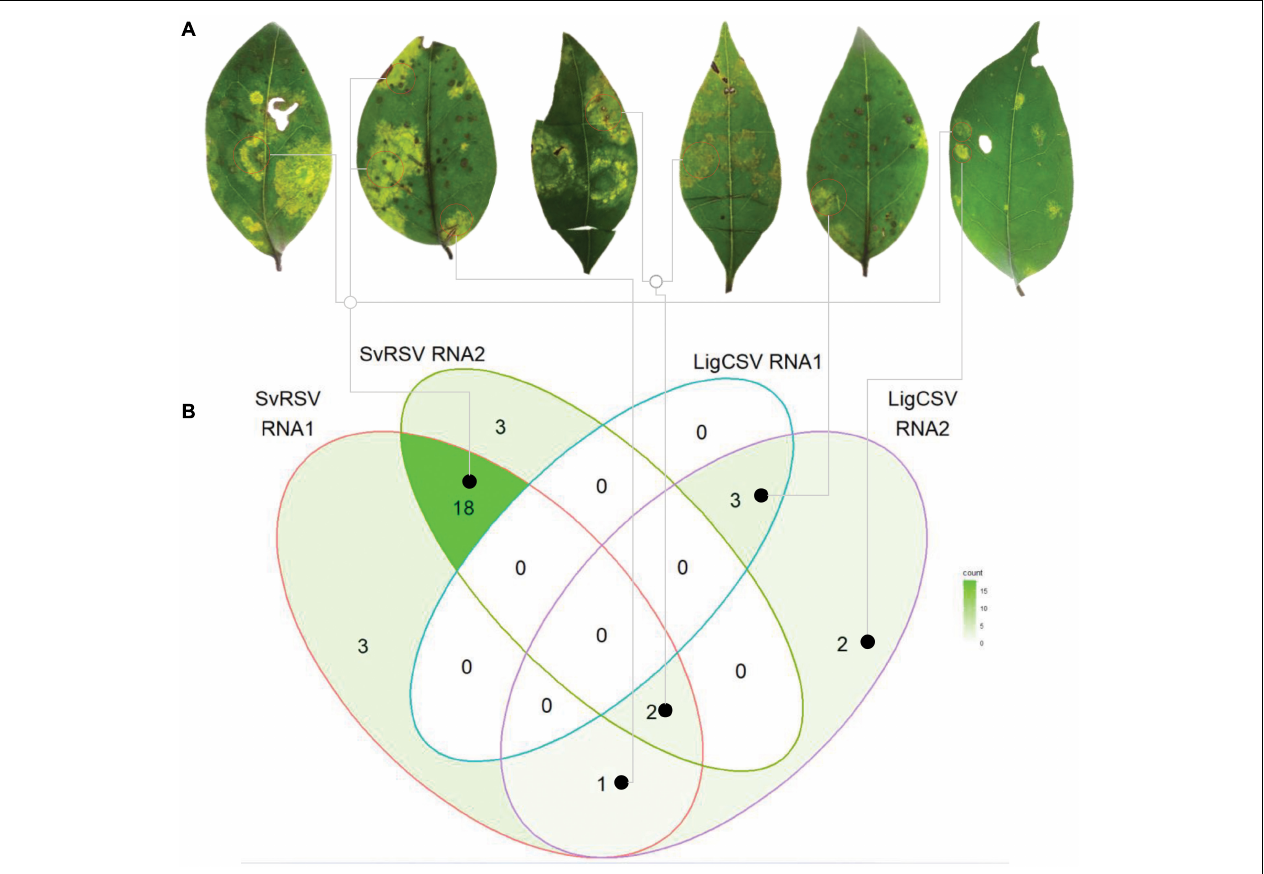
FIGURE 9 | Distribution of SvRSV and LigCSV in isolated lesions found in leaves of Ligustrum lucidum plants of the sample Crb1. (A) Leaf discs comprising viral symptoms were collected and independently processed for the specific detection of RNA1 and RNA2 of each virus. (B) The Venn diagram represents the general distribution of the detected viral genome RNA molecules across the 54 analyzed lesions. Gray lines link lesions to the viral RNA detection indicated in the